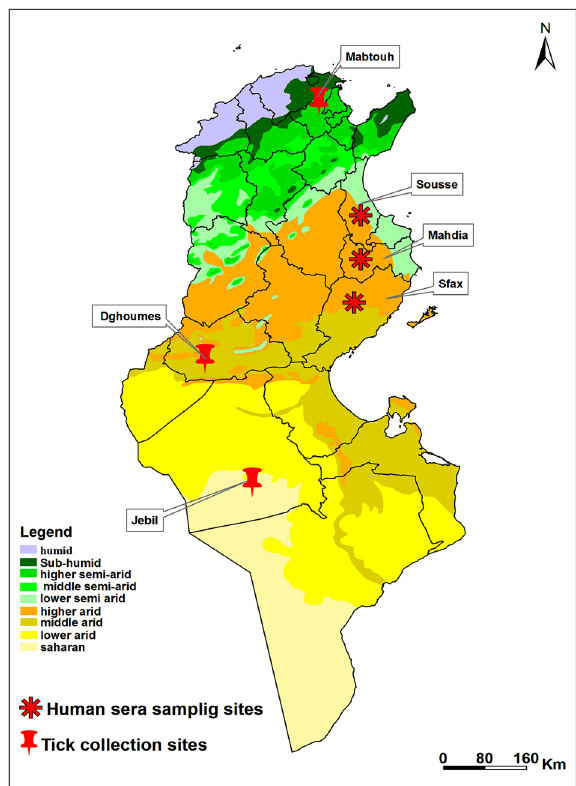
Figure 1. Bioclimatic map of Tunisia showing sites of sera and tick